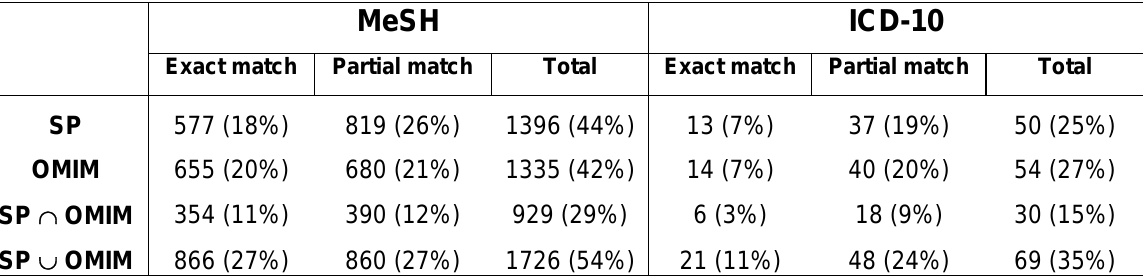
Table 2: Mapping of 3197 disease comment lines of Swiss-Prot on MeSH and ICD-10 terms. SP ∩ OMIM means that both mappings correspond to the same MeSH